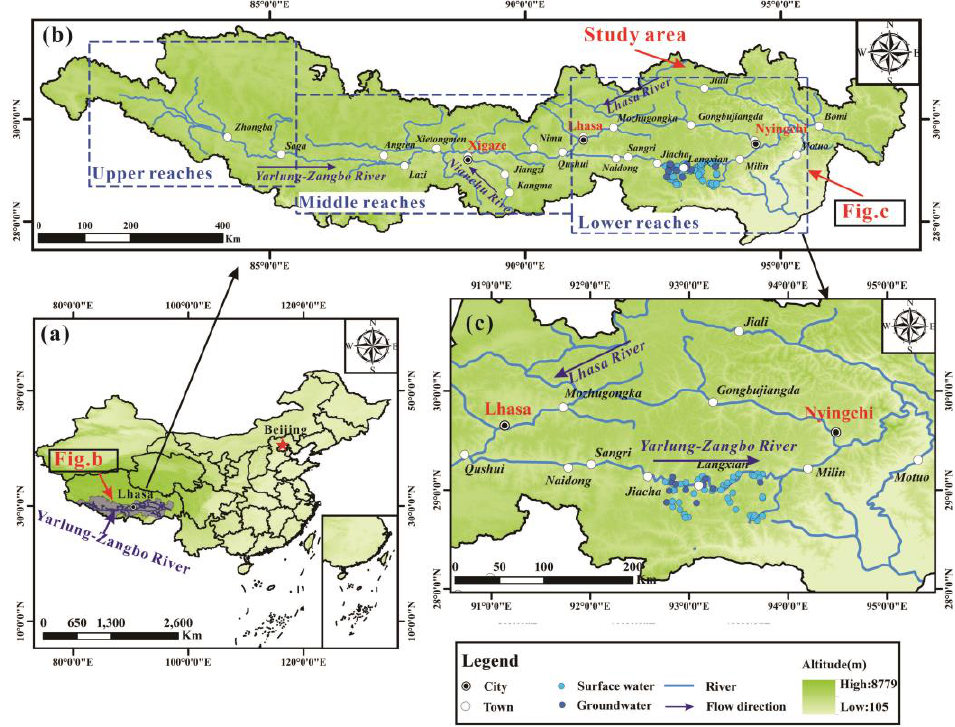
Figure 1. ( a ) Location of the Yarlung Zangbo River in China; ( b ) spatial characteristic of the Yarlung Zangbo River; ( c ) distribution of surface water and groundwater sampling points in the lower reaches of the Yarlung Zangbo River.